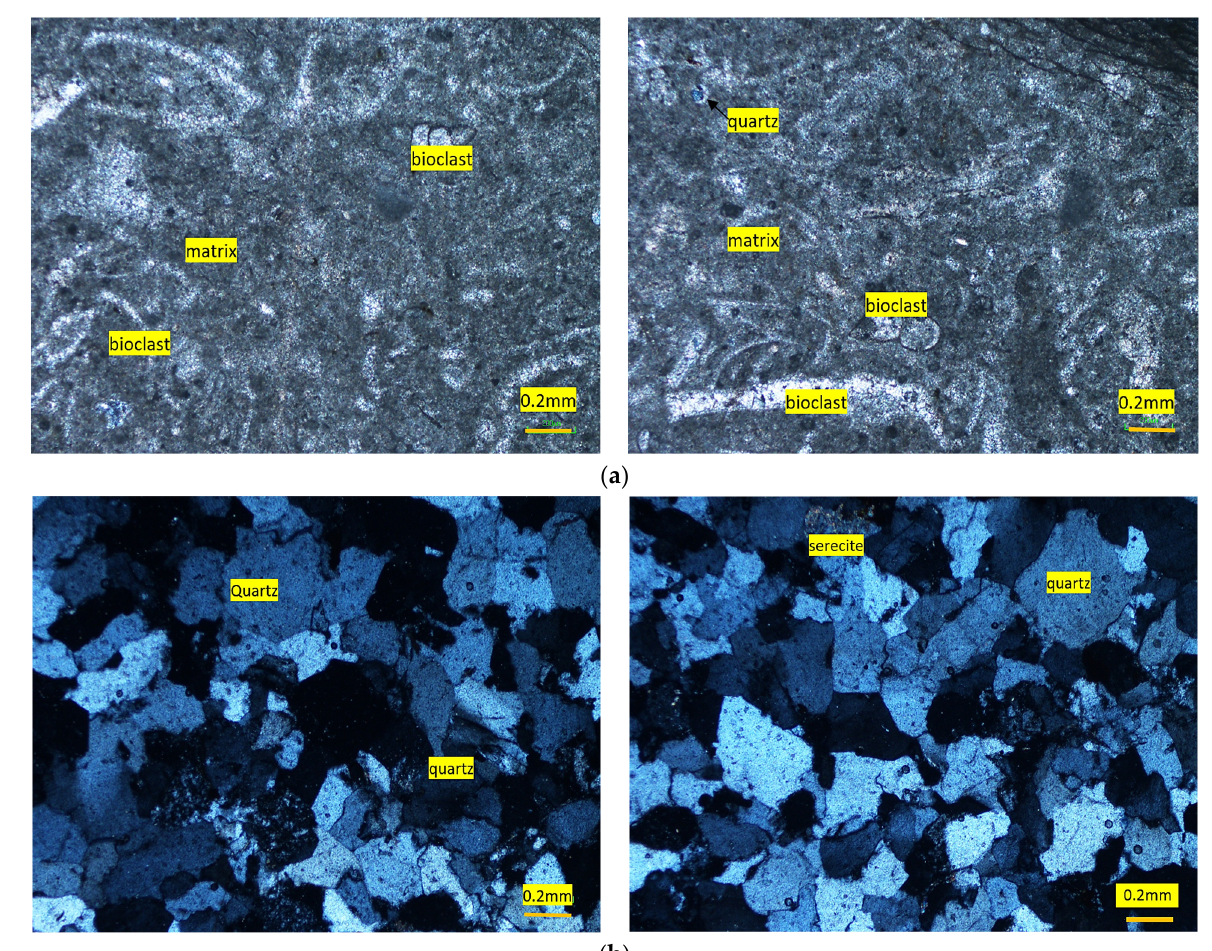
Figure 7. Mineralogical composition of Orakzai aggregate ( a ) limestone, ( b ) quartzite. Microscopic calcite veins also crosscut the rock samples (Figure 8). Patches of coarse- grained euhedral crystalline calcite were also found occasionally. Rigorous effervescence with diluted HCl further confirms the abundance of calcite (CaCO 3 ). with diluted HCl further confirms the abundance of calcite (CaCO 3 ).